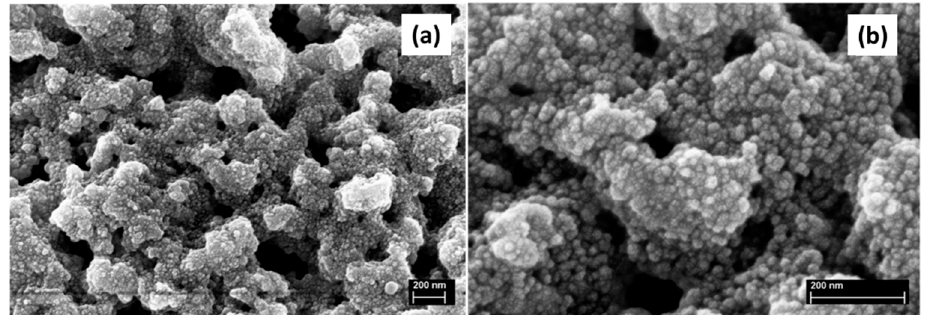
Figure 33. ( a ) SEM images of the MICROSCAFS loaded with TiO 2 NPs; ( b ) magnified view of ( a ). Scale bar: 200 nm. Reprinted from the open access paper by A.C. Marques, M. Vale, D. Vicente, M. Schreck, E. Tervoort, M. Niederberger, “Porous Silica Microspheres with Immobilized Titania Nanoparticles for In-Flow Solar-Driven Purification of Wastewater”, Glob. Challenges 5 (2021) [3].